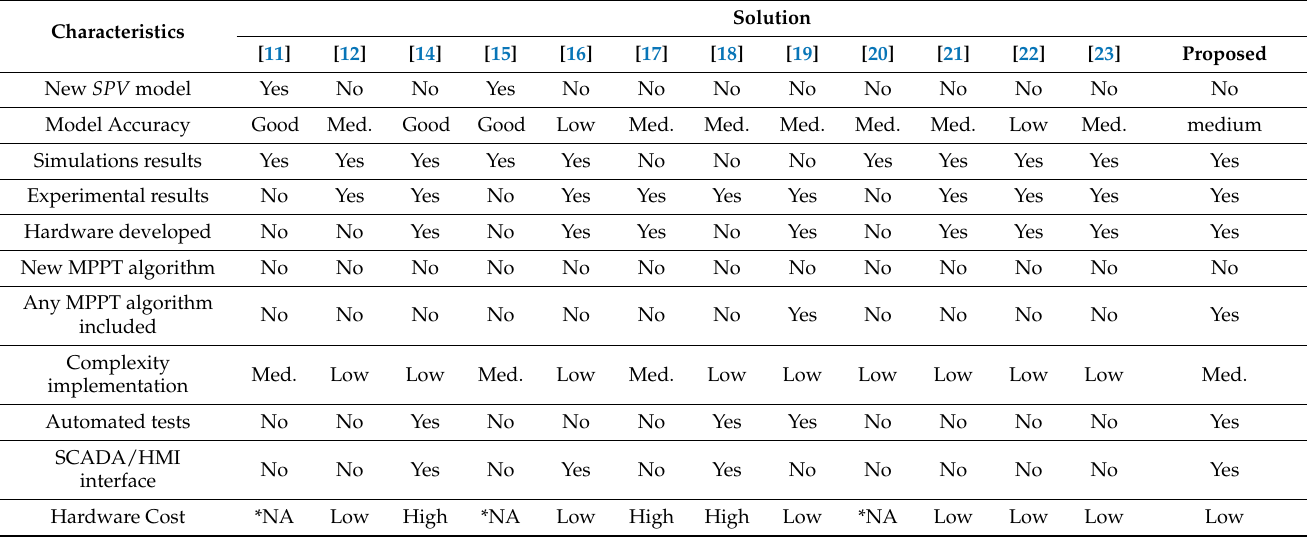
Table 7. Comparison between SPV simulators proposed in the